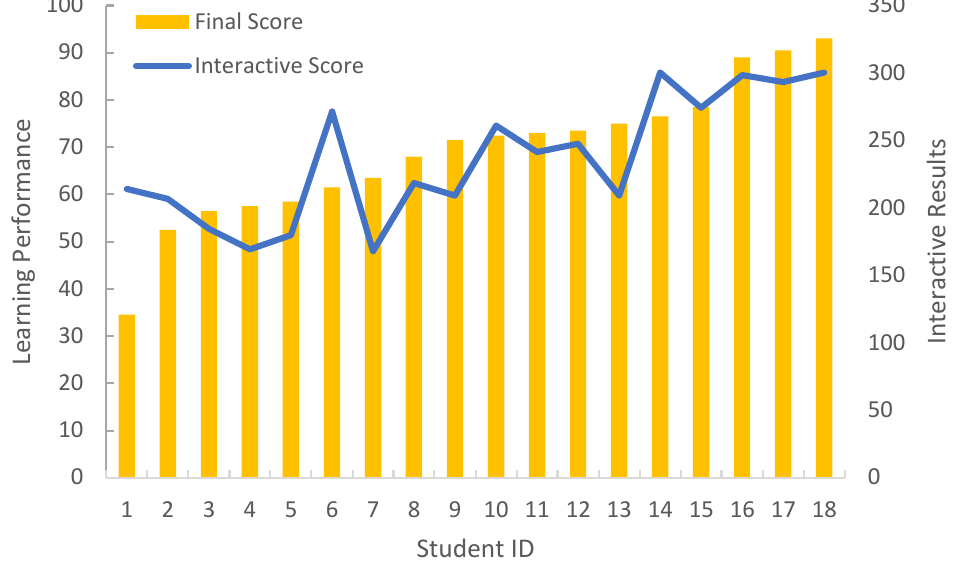
Figure 4. Comparison on the impact of interactive results on learning performance.